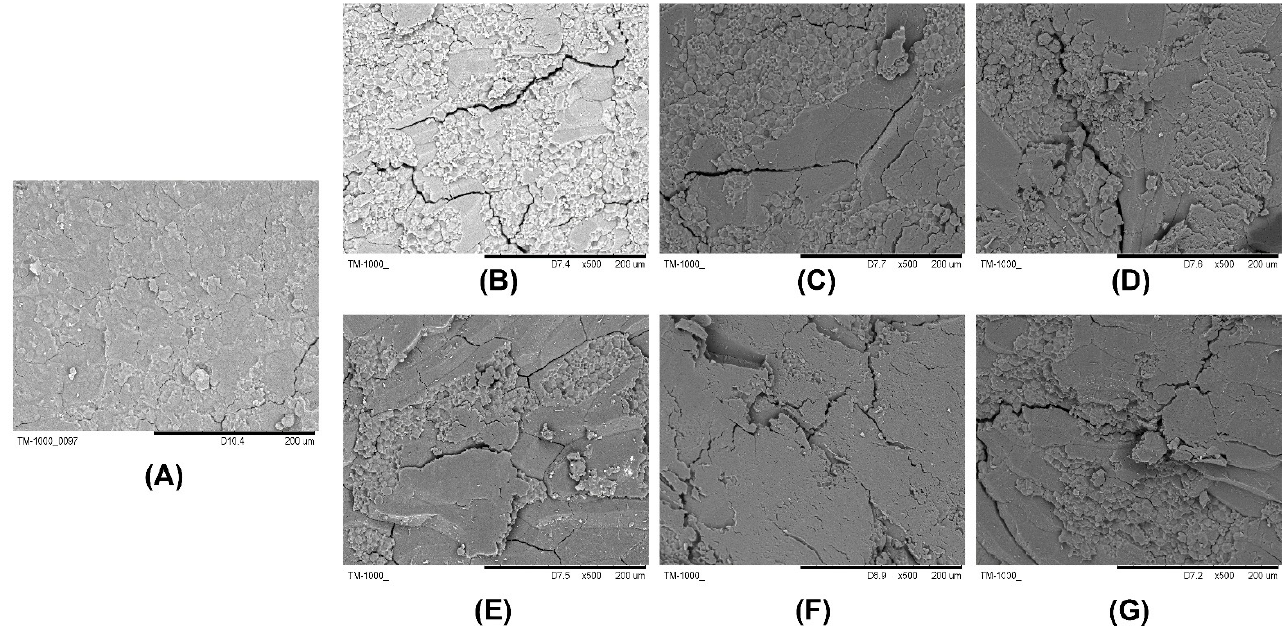
Figure 2. Electron microscope profiles of rice (200 µ m) at different storage temperatures. ( A ) Mor- phological images of rice stored on day 0. ( B – D ) are the morphological images of rice on the 90th day of storage at 15 ◦ C, 25 ◦ C, and 35 ◦ C storage temperature, respectively. ( E – G ) are the morphological images of rice on the 180th day of storage at 15 ◦ C, 25 ◦ C, and 35 ◦ C storage temperature,